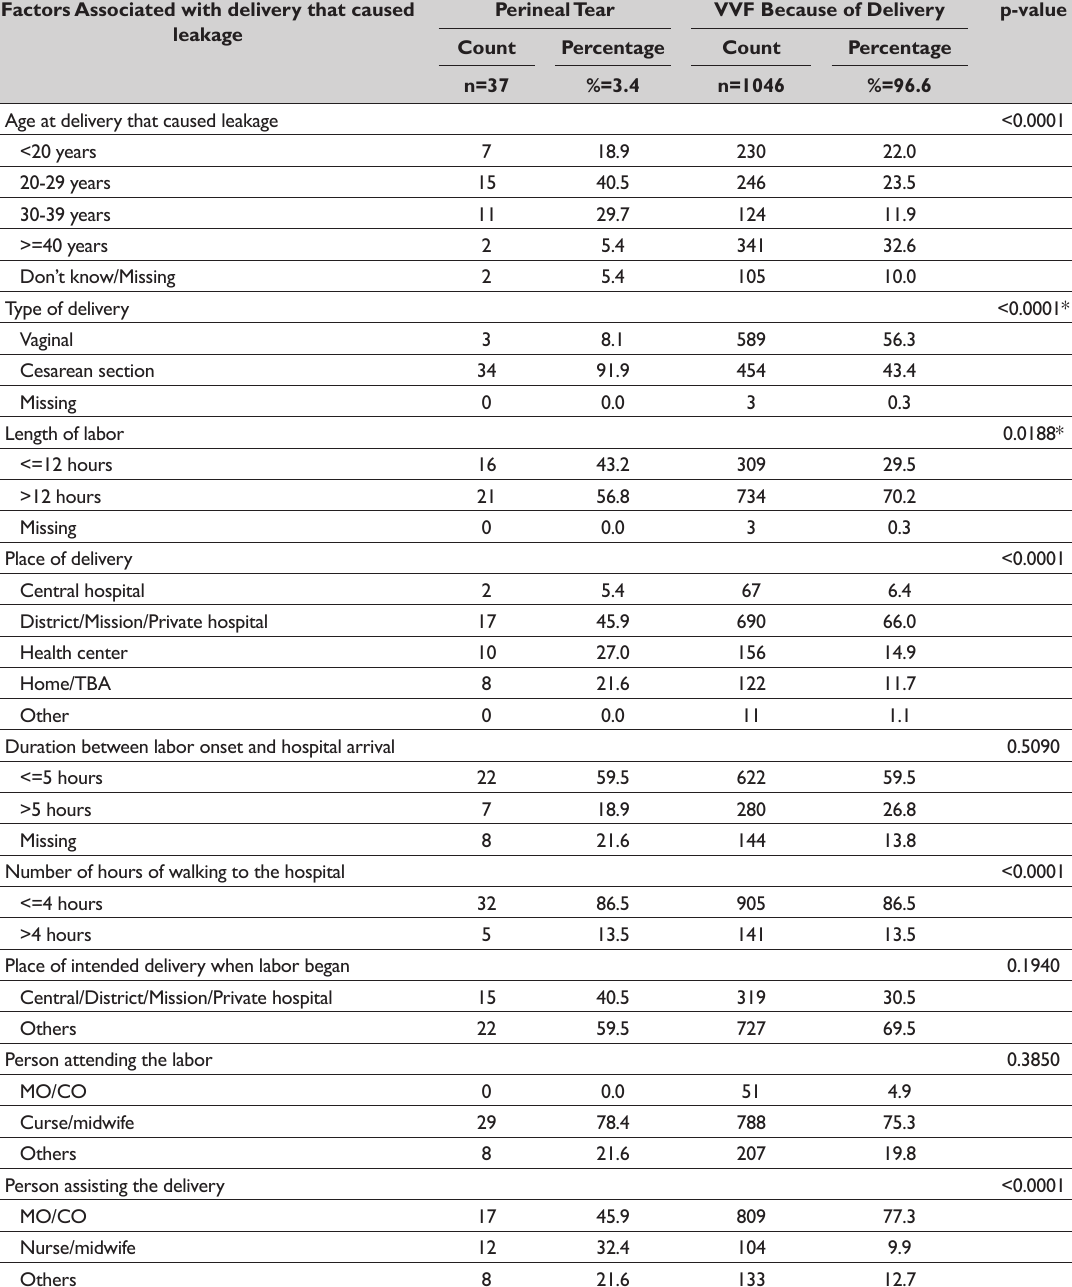
Table 2: Demographic data for factors related to the delivery leading to vesicovaginal fistula (VVF) or perineal